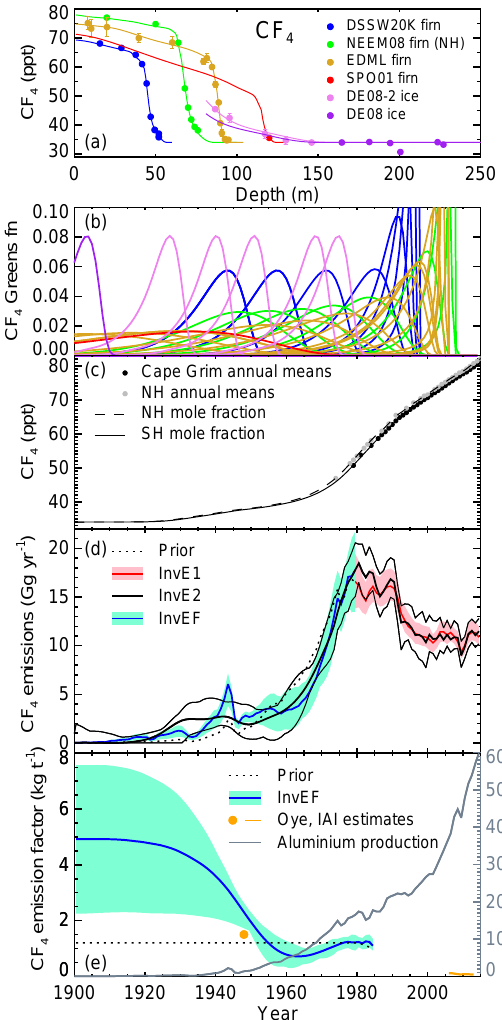
Figure 2. (a) Depth profiles of CF 4 mole fraction in the firn and ice. Lines show model results corresponding to inferred emissions from InvE2; symbols are measurements with 1 σ uncertainties. (b) Green’s functions from the CSIRO firn model (colours correspond to those in panel a ). (c) Time history of mole fraction in the North- ern Hemisphere (NH, dashed line) and Southern Hemisphere (SH, solid line) calculated with emissions inferred by InvE2. Symbols show annual values determined from atmospheric measurements in each hemisphere. (d) Emissions inferred from the three inver- sions, with 95% confidence intervals. The dotted line shows the prior estimate based on a constant emission factor. (e) Emission factor inferred by the InvEF inversion with 95% confidence inter- vals (blue) and constant prior (dotted). Emission factor estimated by Oye et al. (1999) for 1948 (orange circle) and recent estimates by the International Aluminium Institute (2014) (orange line, lower right corner). Primary aluminium production (U.S. Geological Sur- vey, 2014; International Aluminium Institute, 2014) in 10 6 t (mil- lion metric tonnes) is shown with the grey line (right